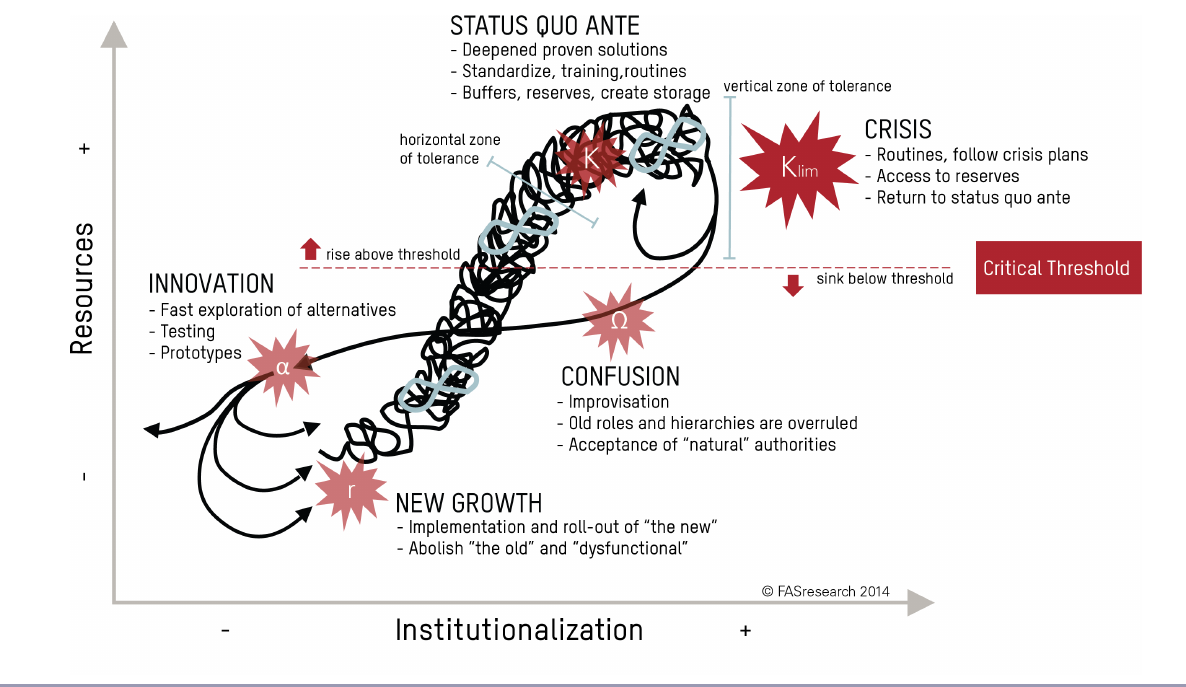
Fig. 3. Adaptive cycle applied to social systems. Stages in this cycle are similar to ecological stages, from new growth to status quo, to confusion, and innovation. The differentiation between crises that remain within the threshold and those that lead to dissolution are indicated by the vertical range of